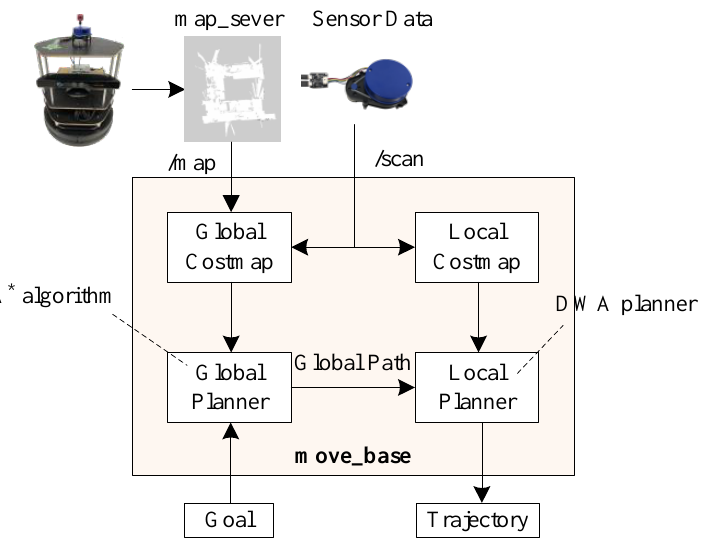
Figure 8. Navigation Workflow Architecture.